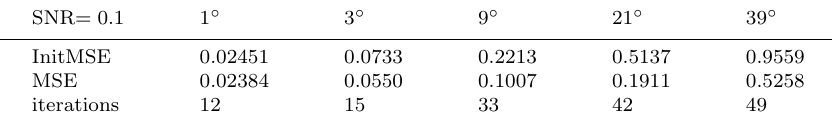
Table 2. Orientation refinement results for the simulated noisy particle images. SNR= 0 . 1